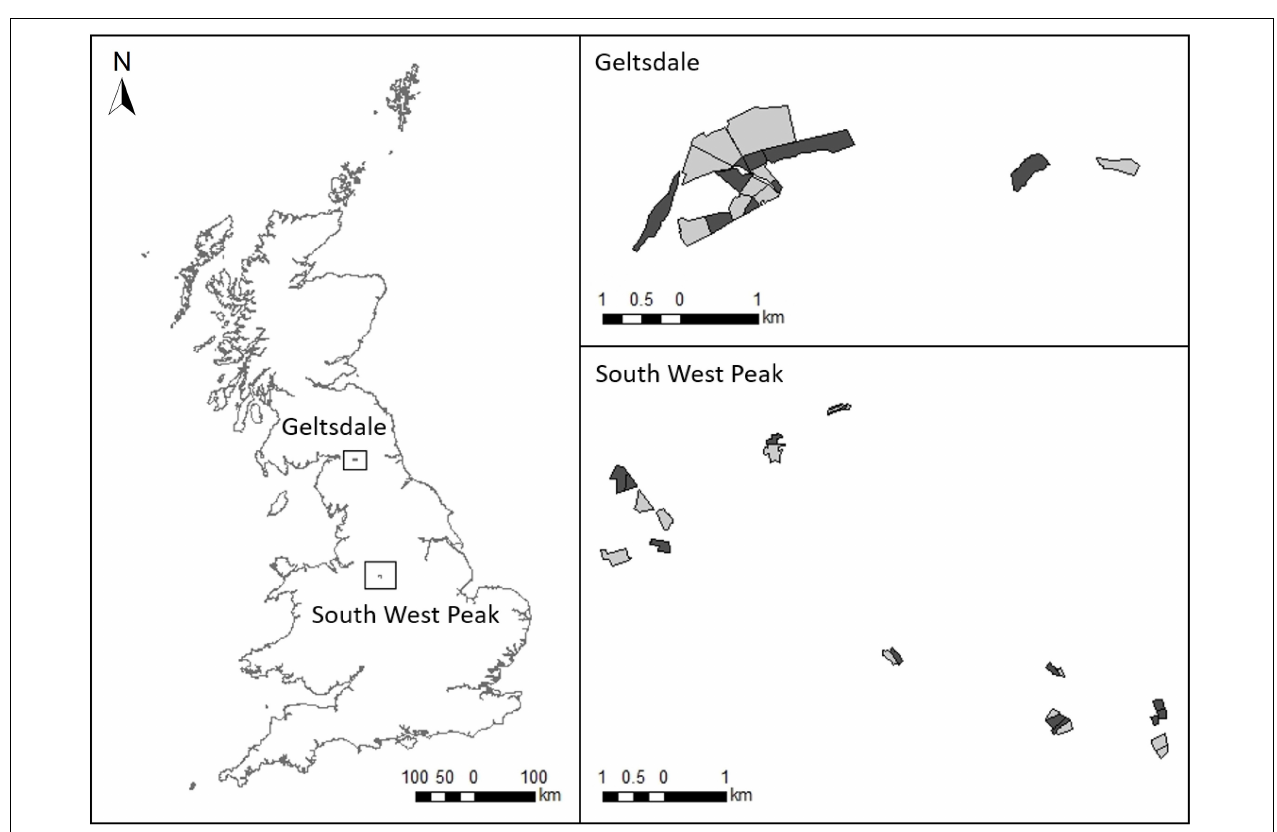
FIGURE 1 | The two study regions showing locations of treatment fields (rush management, light grey) and control fields (no rush management, dark